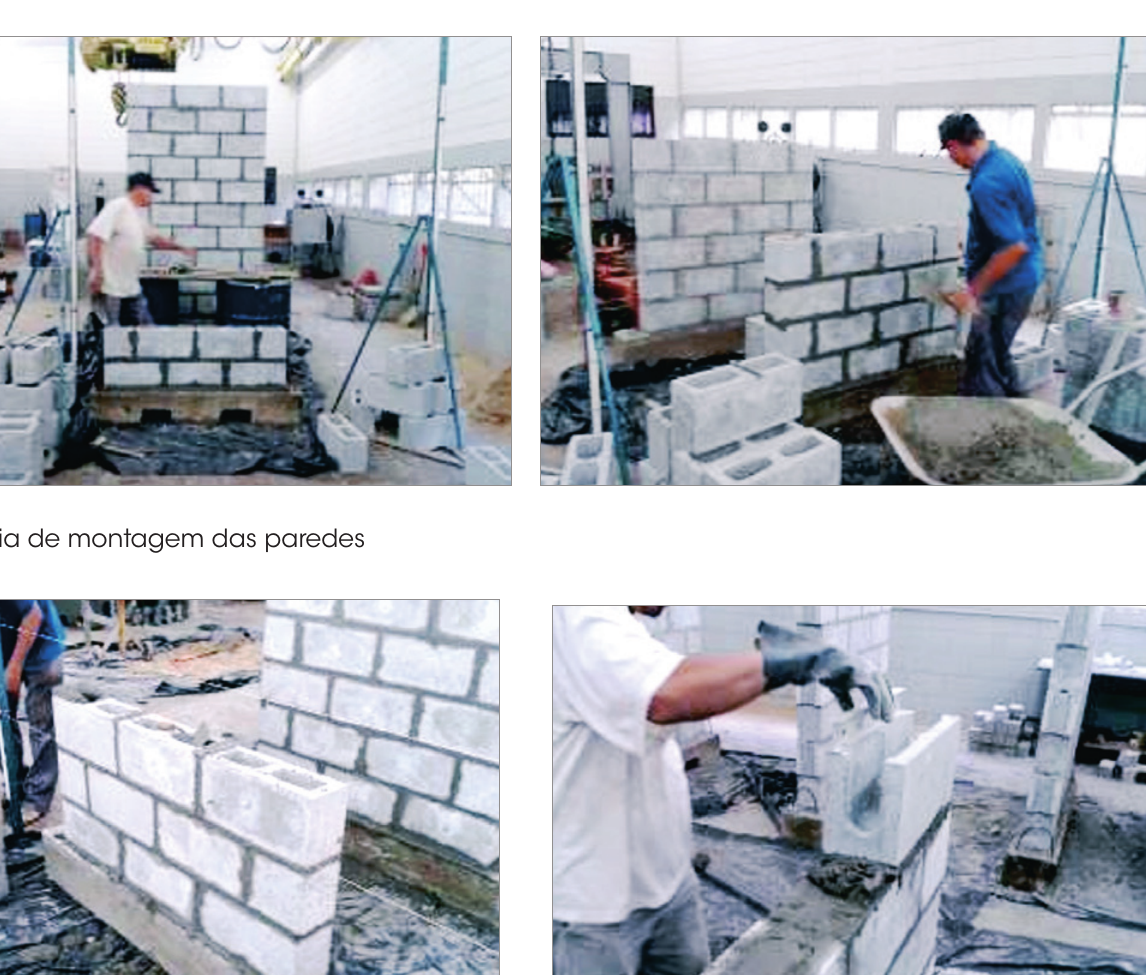
Escantilhões para auxiliar na construção das paredes